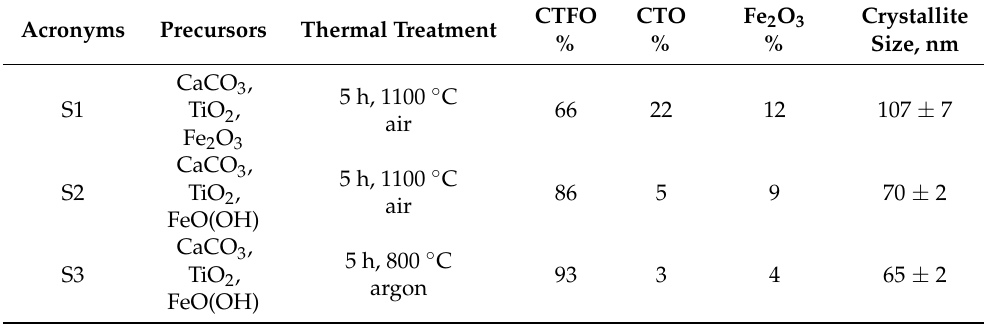
Table 1. Preparation procedures, compositions, and acronyms of the CTFO samples.